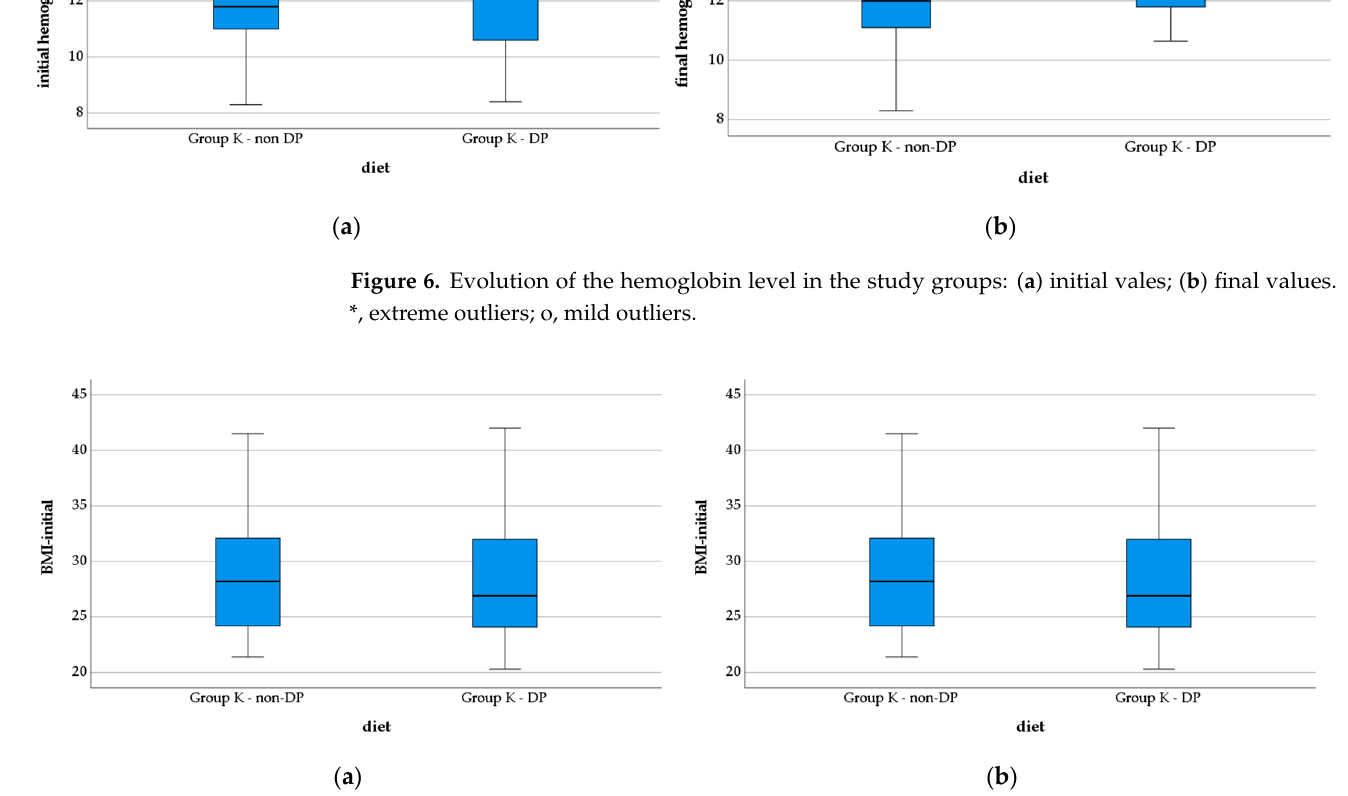
Figure 7. Evolution of the BMI in the study groups: ( a ) initial vales; ( b ) final values.